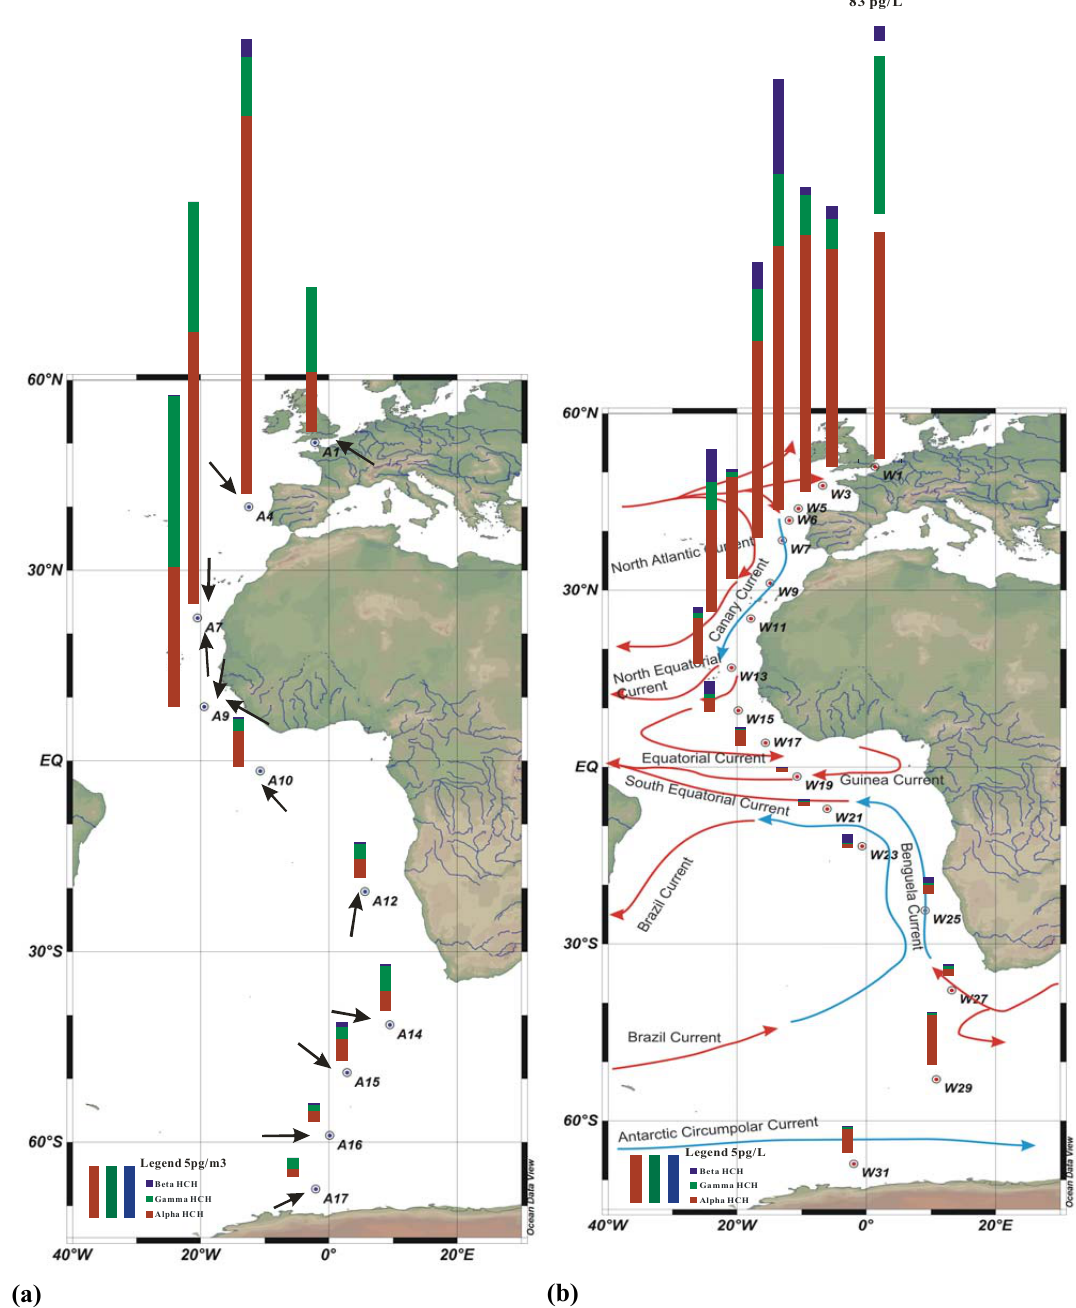
Figure 1. Fig. 1. (a) Gaseous (pgm − 3 ) and (b) dissolved (pgl − 1 ) concentrations of α -, γ - and β -HCH in the Atlantic and the Southern Ocean. The